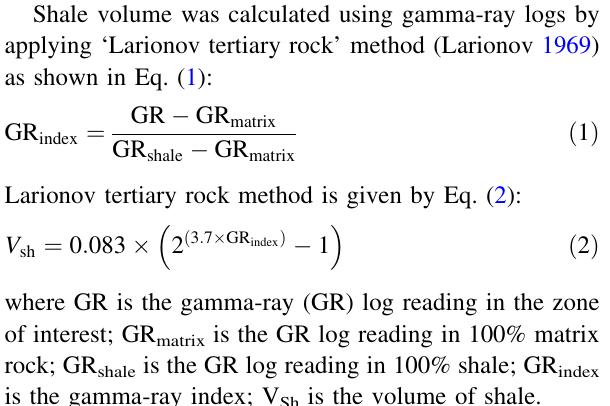
where Net Int. is the interval of the net pay section of the reservoir; Gross Int. is the interval of the entire reservoir.